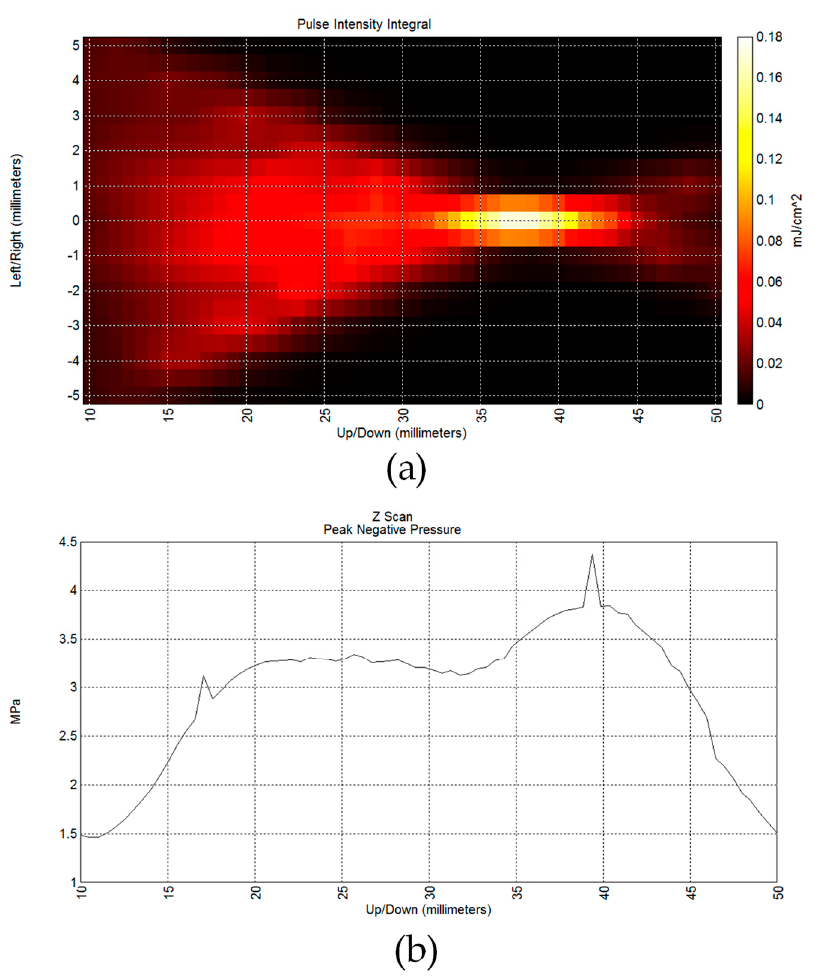
Figure 22. Measured underwater acoustic field using the eight-channel pulse actuator ( a ). The maximum 4 MPa was obtained at the focal plane after beamforming ( b ). Sensors 2019 , 19 , 5063 20 of 22